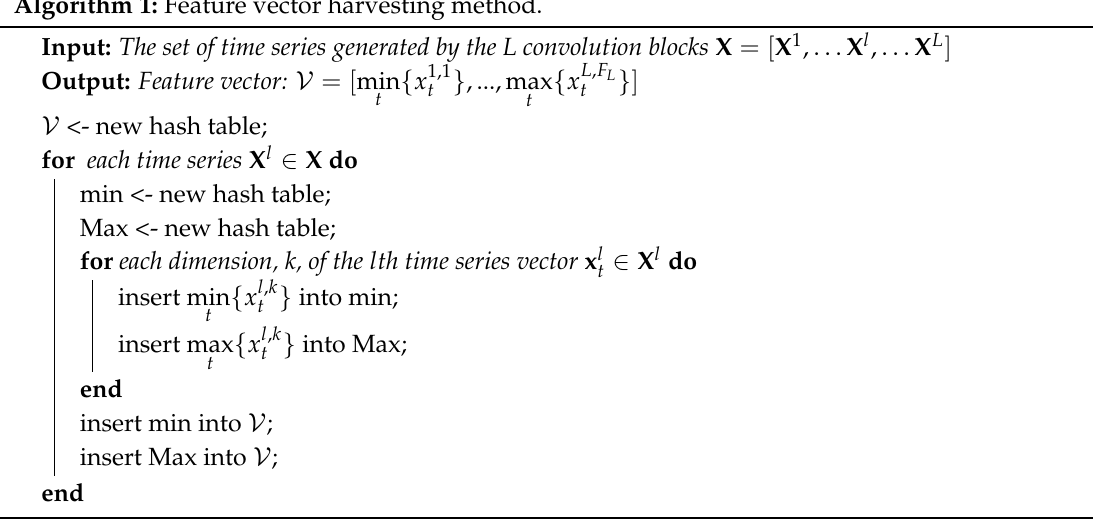
Algorithm 1: Feature vector harvesting method.